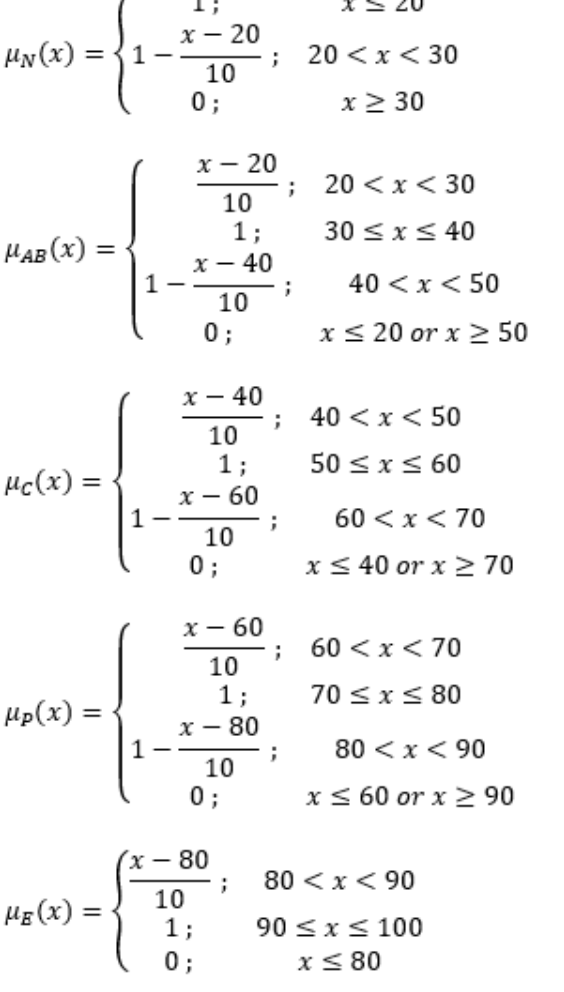
Figure 2. Fuzzy weights membership functions of current knowledge level.